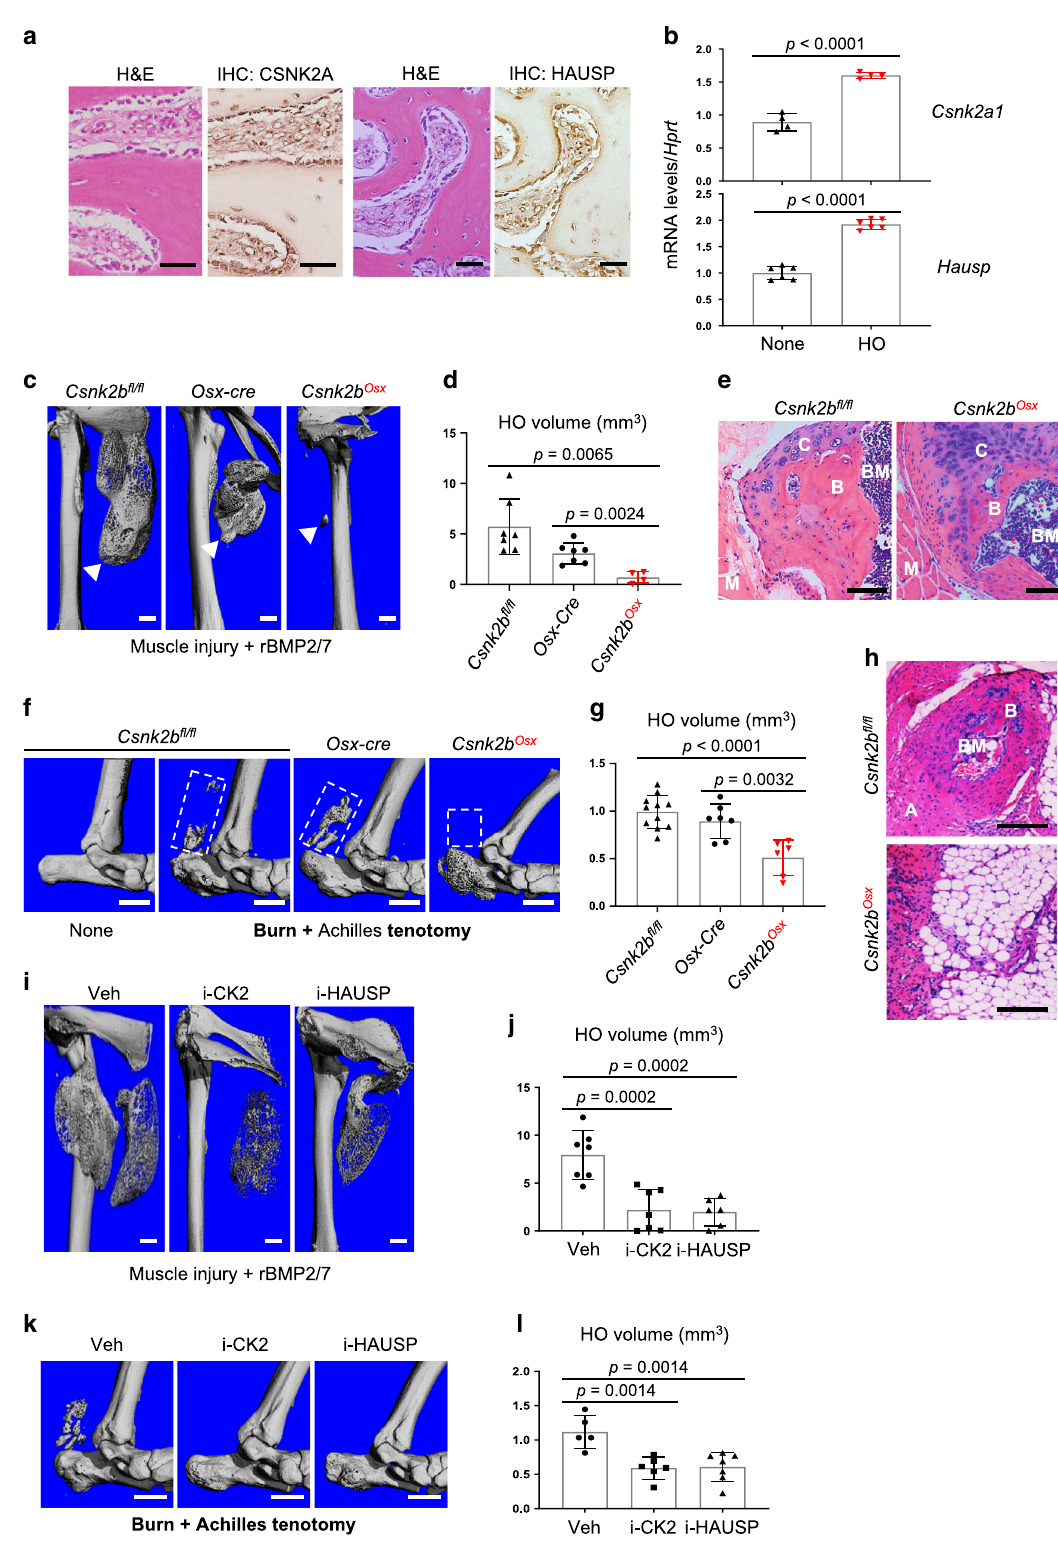
for all pairs of groups. The GraphPad PRISM software (ver.8.3.0, La Jolla, CA) was used for statistical analysis. P <0.05 was considered statistically signi fi cant. Reporting summary . Further information on research design is available in the Nature Research Reporting Summary linked to this